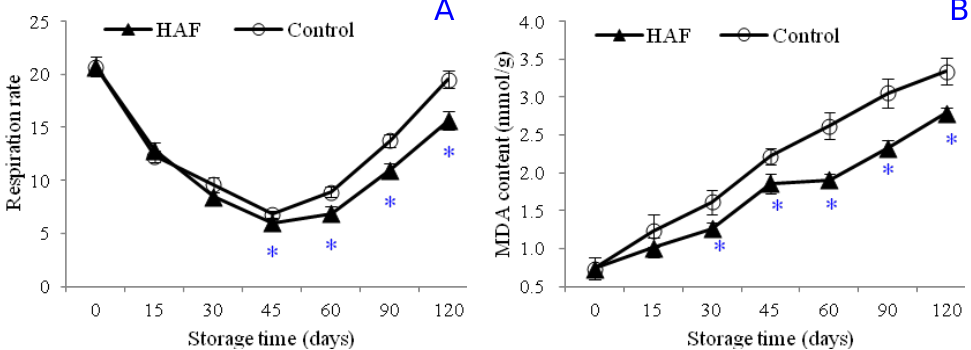
Figure 3. Effects of HAF treatment on respiration rate ( A ) and MDA content ( B ) of navel orange fruits during 120 days of cold storage at 6 °C. Each value was presented as the mean ± standard error (SE) of three replicates. The symbol * represents significantly lower values for the HAF-treated fruits than for the control fruits. The significant difference was determined according to the independent samples t -test ( P < 0.05) on each storage day.